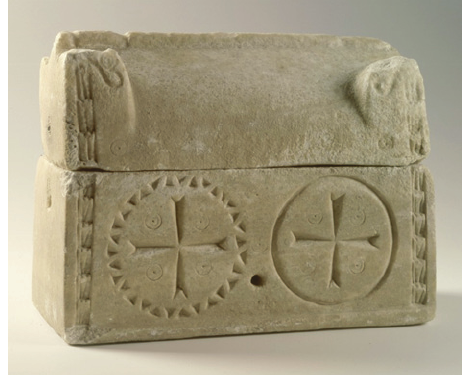
Figure 7: Reliquary sarcophagus (Berlin No.10/87). © Skulpturensammlung und Mu- seum für Byzantinische Kunst, Staatliche Mu- seen zu